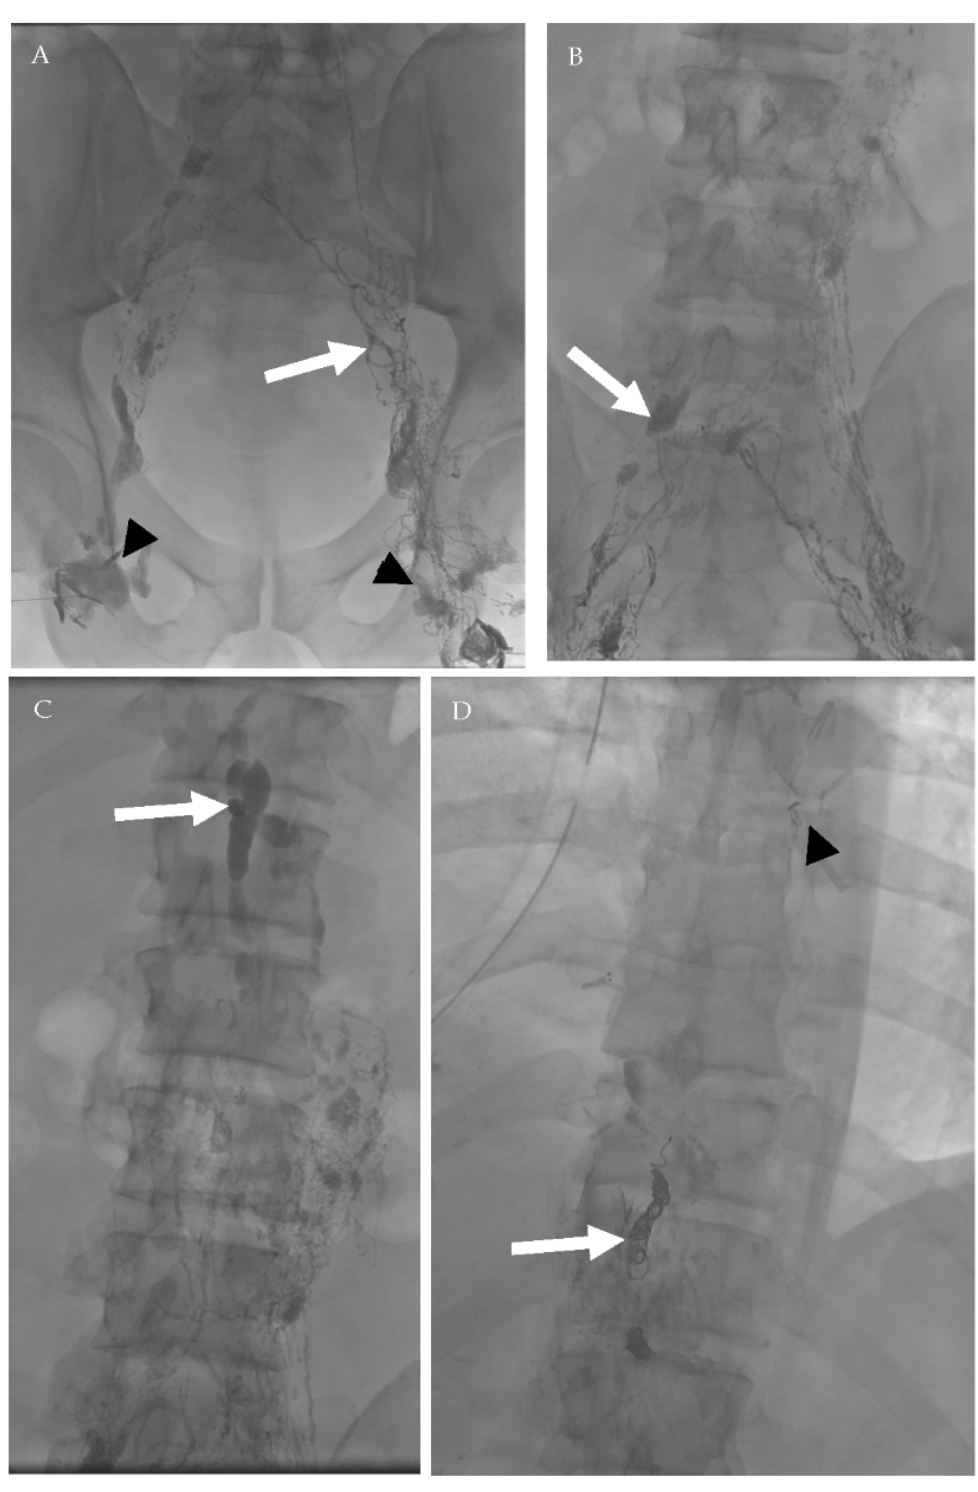
Figure 16. A 39-year-old male patient who underwent surgical resection of esophageal leiomyoma complicated by persistent chylous effusion. Successful percutaneous fluoroscopic-guided thoracic duct embolization using embolization coils. ( A ) Bilateral conventional lymphangiography was done through inguinal lymph nodes (arrowheads) with lymphatic vessels opacification (arrow). ( B ) Subsequent opacification of the lymphatic network and deep lymph nodes (arrow). ( C ) After 81 min, opacification of the cisterna chyle occurred (arrow). ( D ) Deployment of 3 embolization coils (white arrow) in the thoracic duct proximal to the estimated site of leak (arrowhead—surgical clips from previous operations).